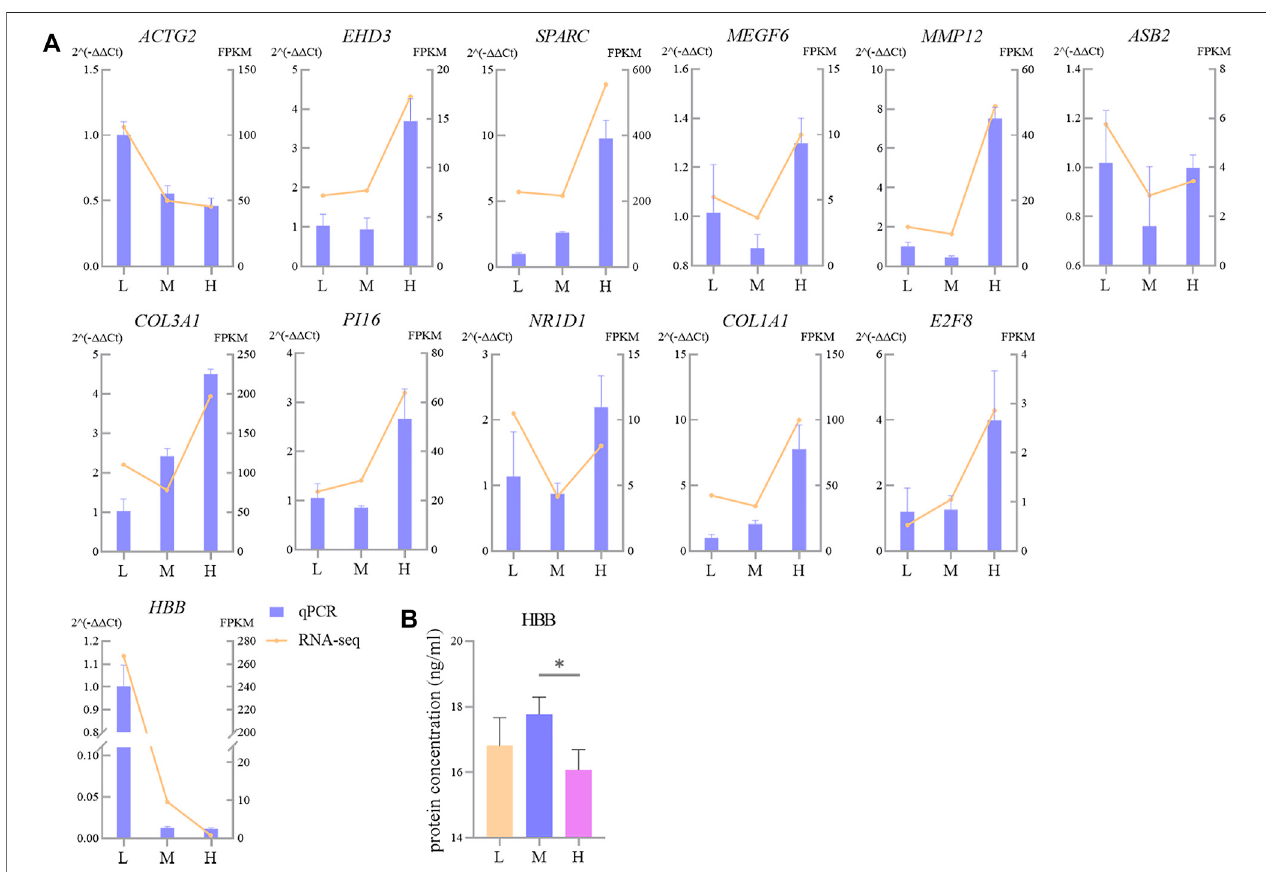
FIGURE9| ComparisonofgeneexpressionlevelsmeasuredusingRNA-seqandRT-qPCRfor14randomlyselectedDEGs (A) andproteinabundanceofHBB (B) . L, M, and H refer, respectively, to low, middle, and high altitudes; the RT-qPCR and ELISA results are presented as mean ± SD for four and six replicates, respectively; * indicates p <